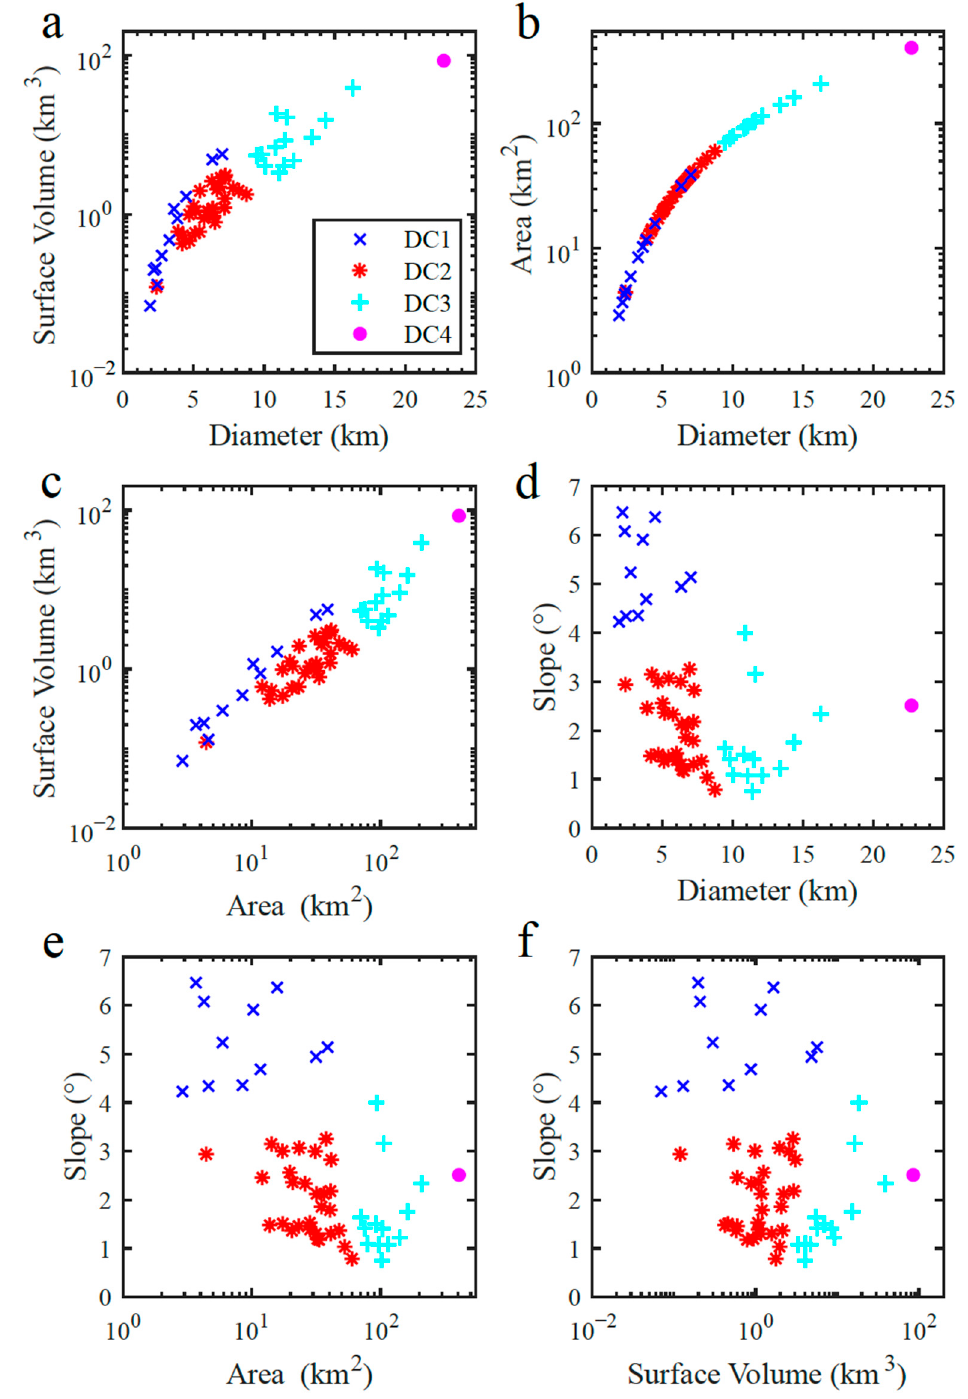
Figure 5. Graphs showing the variation of ( a ) surface volume vs. diameter, ( b ) area vs. diameter, ( c ) surface volume vs. area, ( d ) average flank slope (Slope) vs. diameter, ( e ) average flank slope vs. area, and ( f ) average flank slope vs. surface volume of 54 domes in both the Gardner volcano and the northern mare Tranquillitatis. These domes were grouped into four clusters using an integrated RAC-FCM algorithm, namely dome cluster 1 (DC1, blue), dome cluster 2 (DC2, red), dome cluster 3 (DC3, cyan), and dome cluster 4 (DC4, magenta), respectively. Diameter, area, surface volume, and slope are the selected features for clustering.